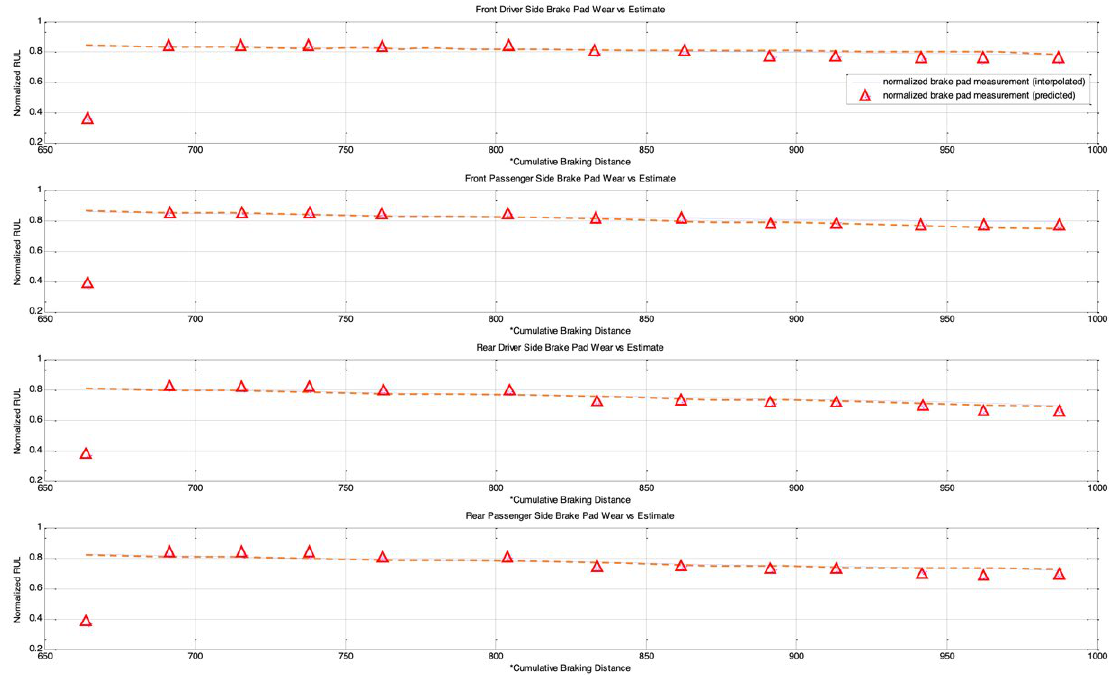
Figure 22. Driver #4, inferred normalized brake wear (dashed-line) vs. predicted brake wear (triangle). Top–bottom shows front driver side, front passenger side, rear driver side, and rear passenger side.